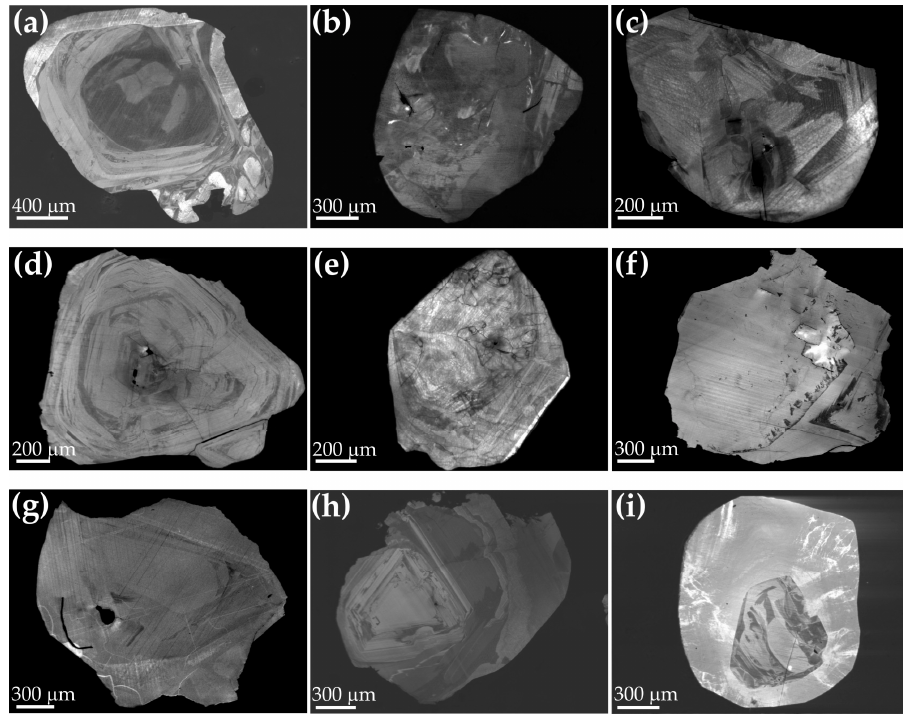
Figure 7. Cathodoluminescence images of polished plates of super-deep diamonds from São-Luiz deposit, Brazil: (a-h) and Kholomolokh alluvial placer (Yakutia): (i). ( a ) SL-34; ( b ) SL-52; ( c ) SL-55; ( d ) SL-16; ( e ) SL-2; ( f ) SL-24; ( g ) C-2; ( h ) SL-82; ( i ) HH-11. (a–h) super-deep diamonds from São-Luiz alluvial placers (Juina, Brazil); (i) super-deep diamond crystal from Kholomolokh placer (Yakutia, Russia).